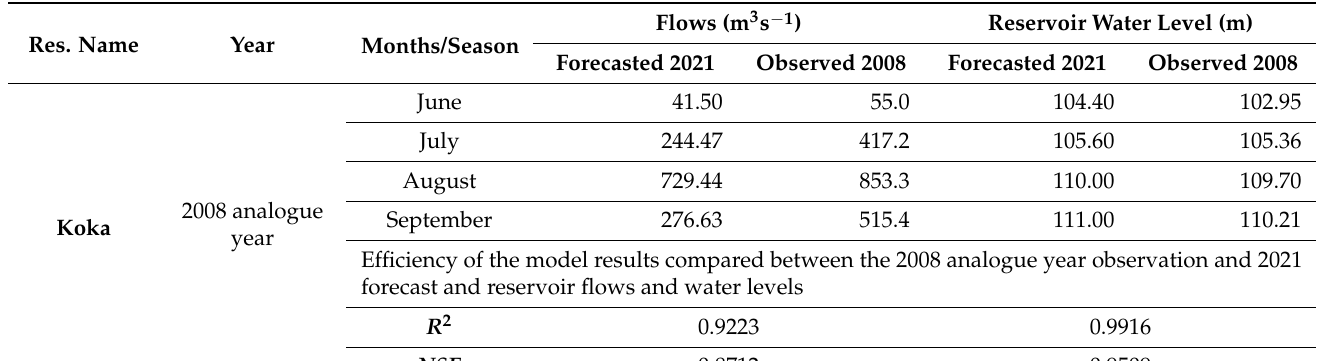
Table 3. Comparison of observation and forecasted flows and water levels for the 2008 analogue